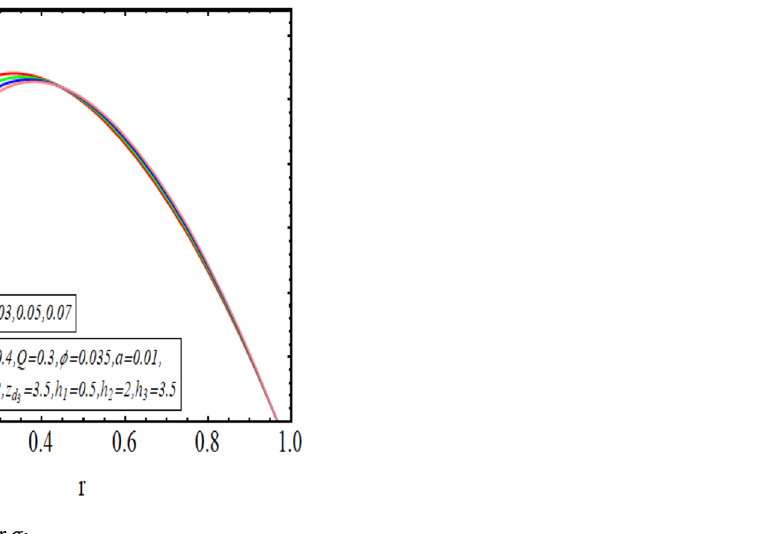
Figure 4. Velocity for σ l